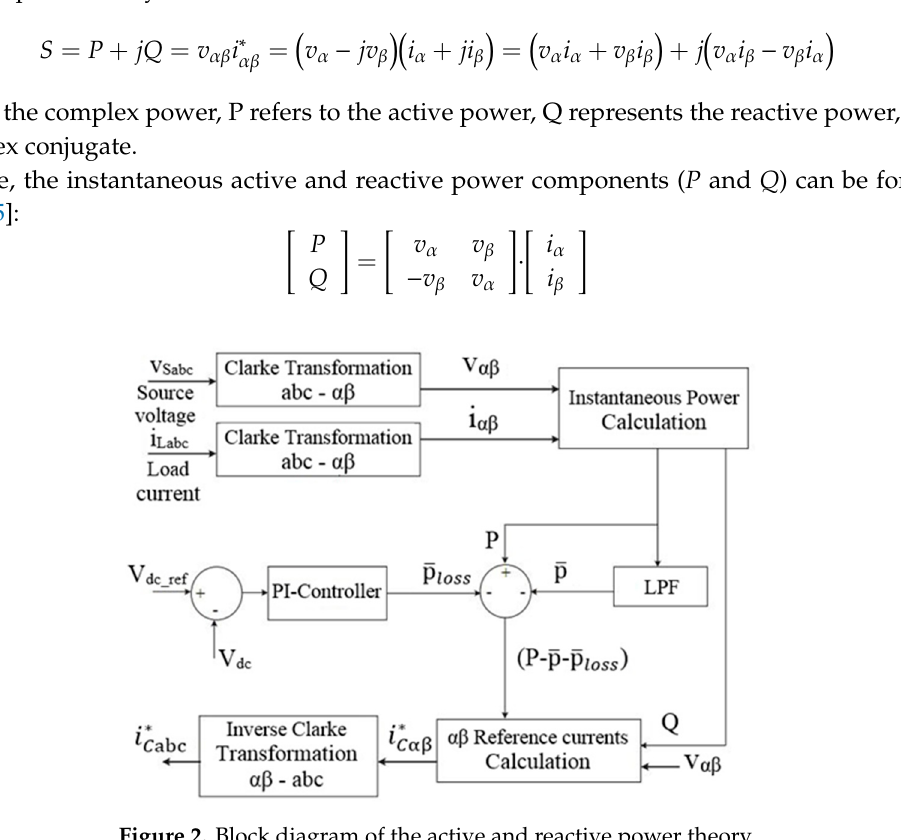
Figure 2. Block diagram of the active and reactive power